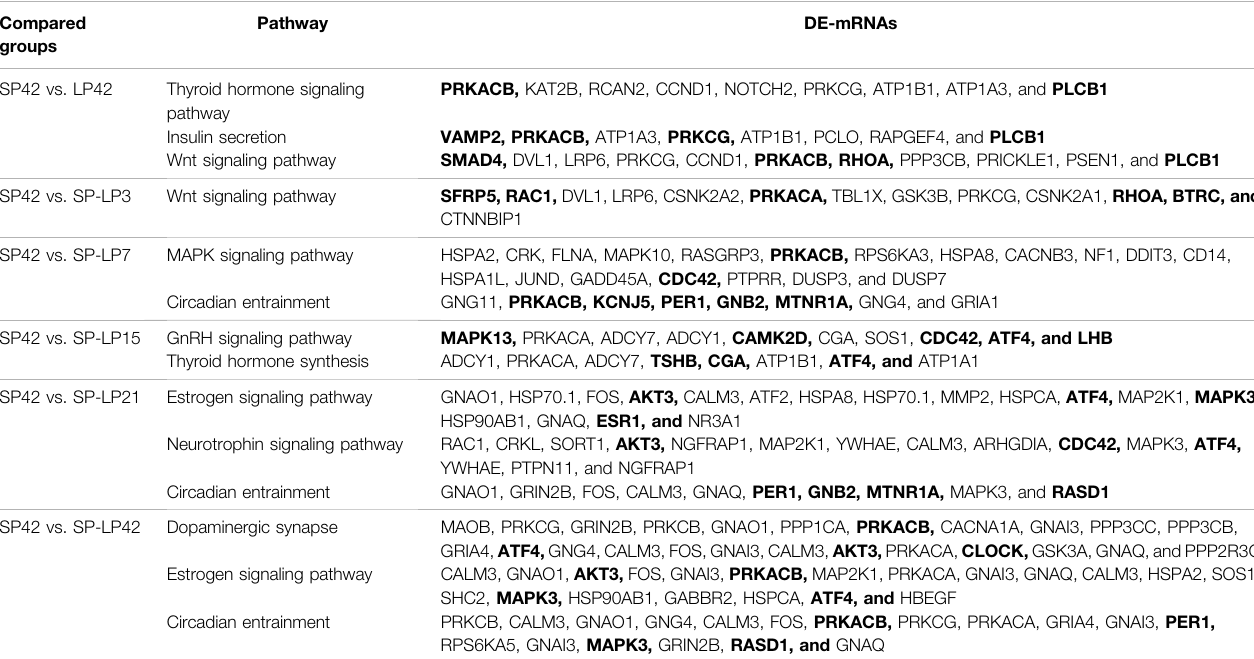
TABLE 4 | Summary of differentially expressed mRNAs involved in photoperiodic responsiveness and ovine estrous seasonality. Compared